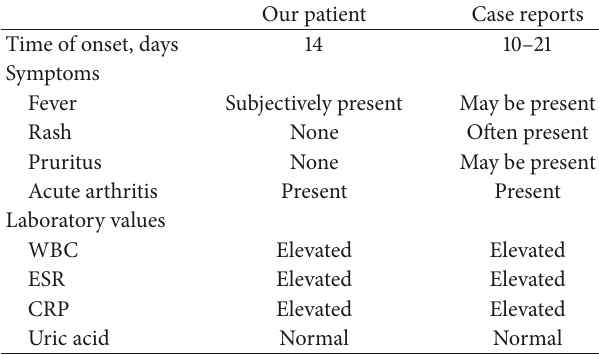
Table 1: Comparison of patient presentation to published